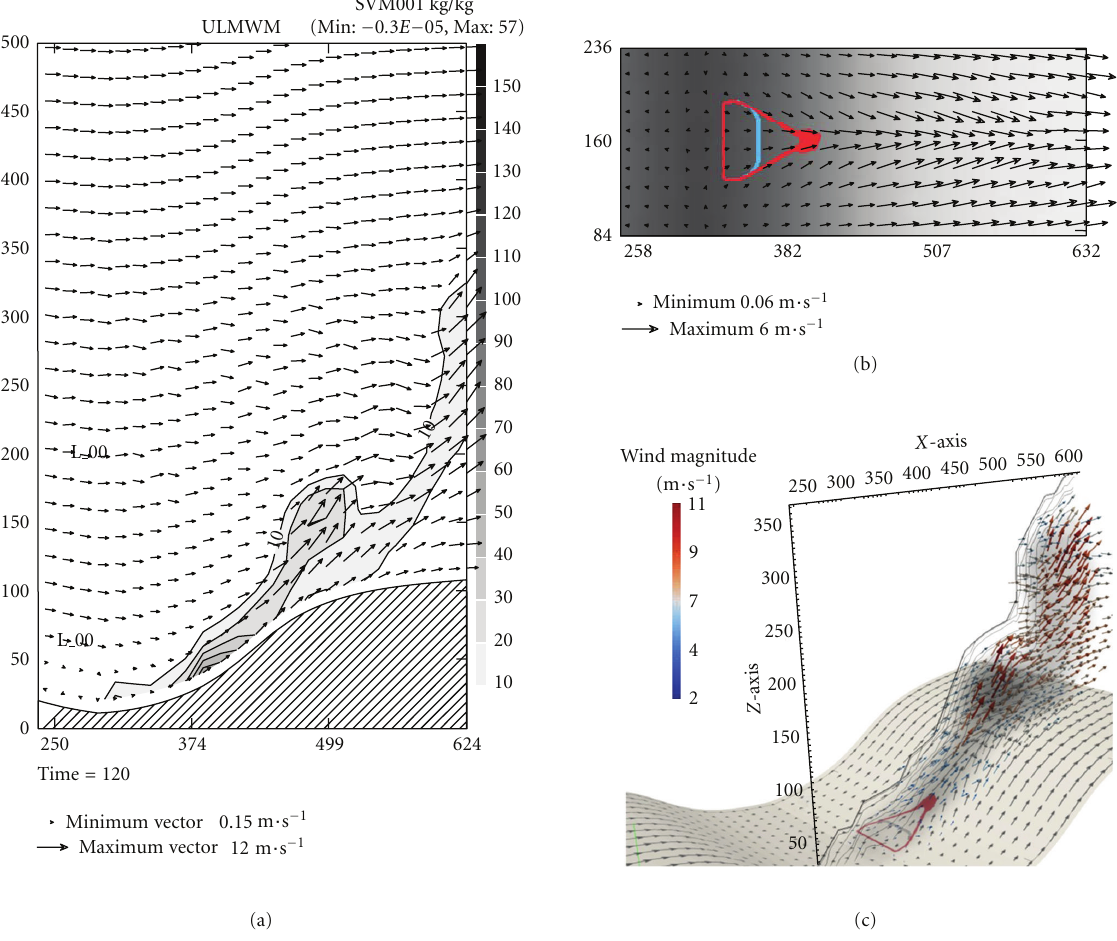
Figure 4: CANYON (a) Horizontal section ( x/y ) at Z= 10 m, fire lines after 120 seconds for the coupled (red) and noncoupled (grey) simulations. Arrows denote the wind vectors at ground level for the coupledcase. (b) Cross-section ( x/z ) of the coupled case at Y = 160 m, shading represents concentration of the injected passive tracer. (c) 3d wind field and passive tracer concentration